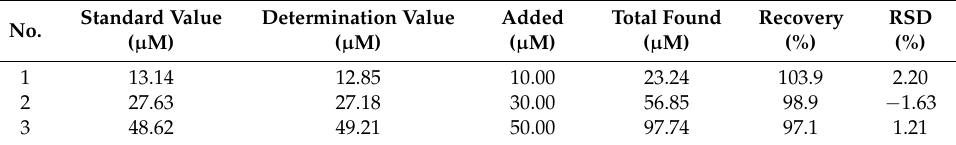
Table 2. Determination results of the dopamine hydrochloride injections ( n =